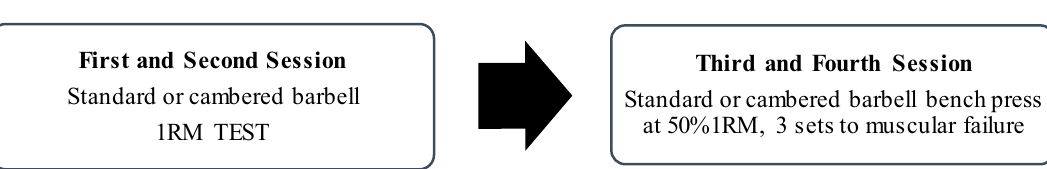
Figure 1. Schematic representation of the experimental sessions protocol.